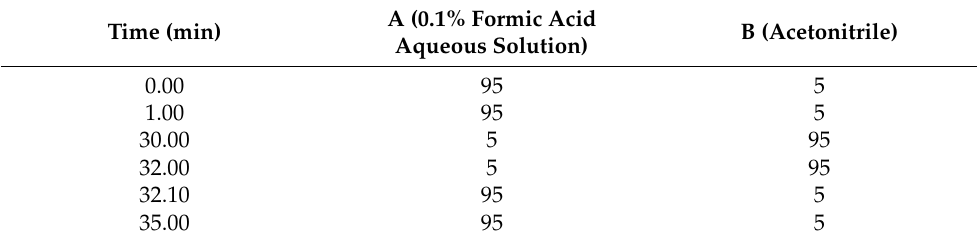
Table 1. Gradient elution procedure of mobile